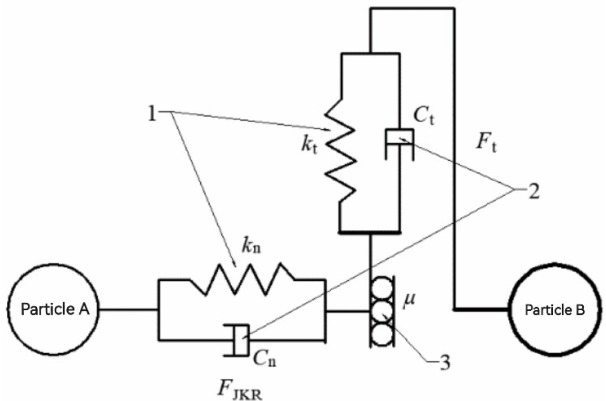
Figure 3. Contact mechanical model: 1. particle stiffness (spring); 2. damper; 3. friction. F JKR is the normal force of JKR model, F t is tangential force, k n is normal stiffness, k t is tangential stiffness, C n